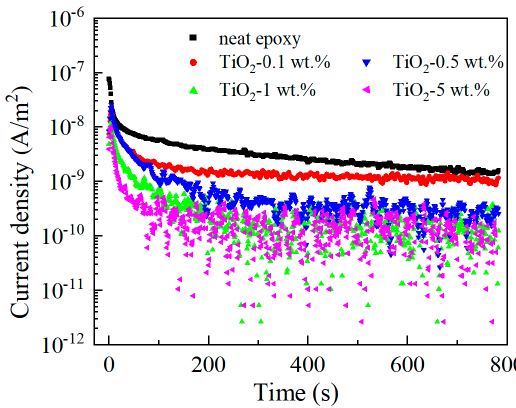
Figure 7. Absorption current of epoxy/TiO 2 samples.